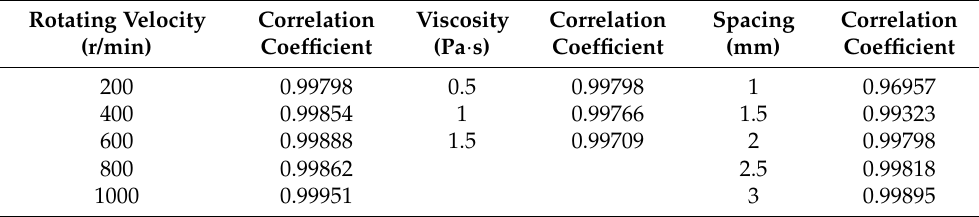
Table 1. Correlation coefficients of curves under different